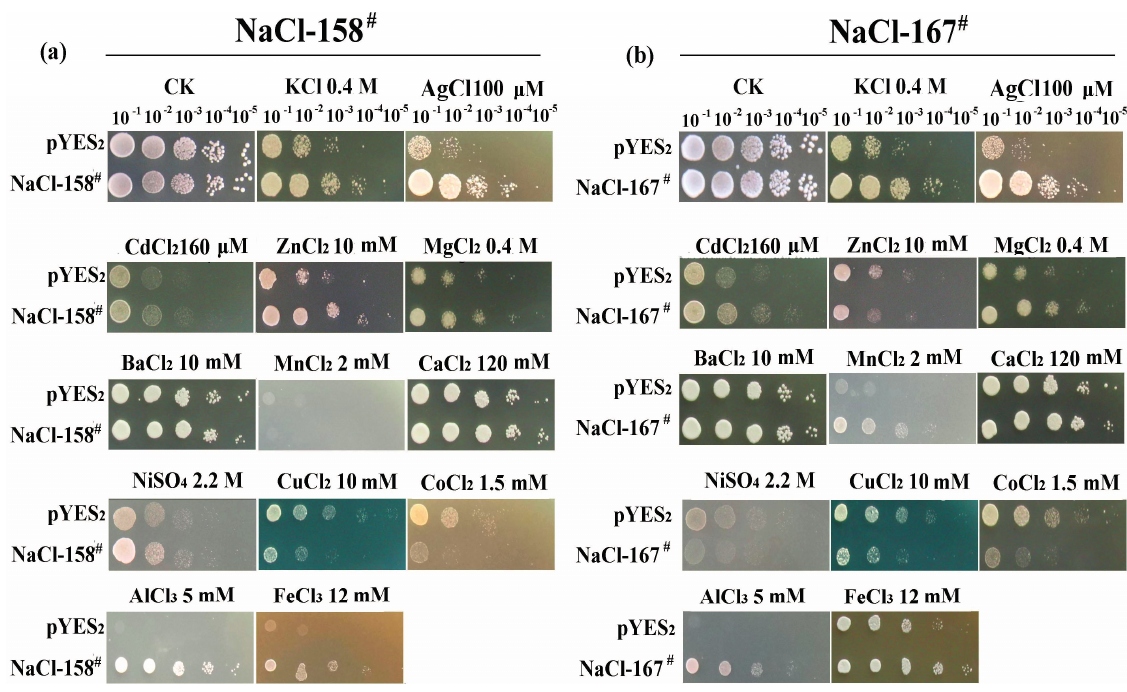
Figure 5. The growth of overexpressing yeast cells in the presence of various metal